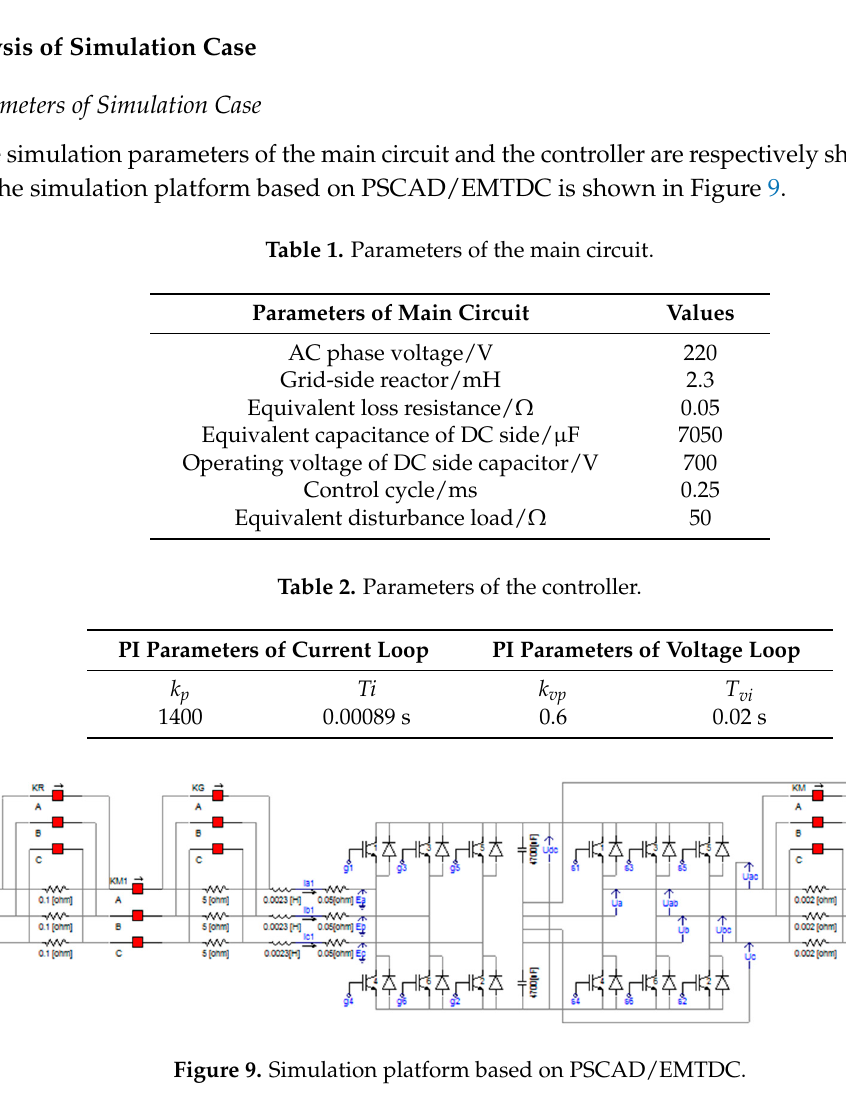
Figure 8. Structure diagram of the control system.